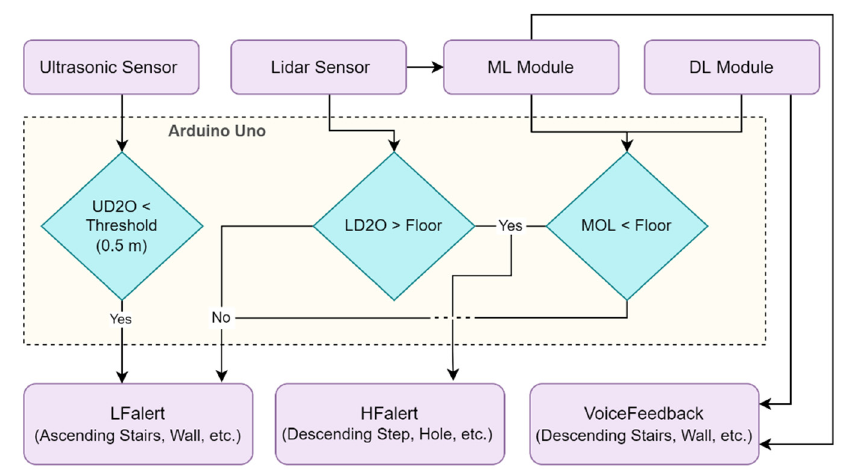
Figure 10. Detection and Warning System.